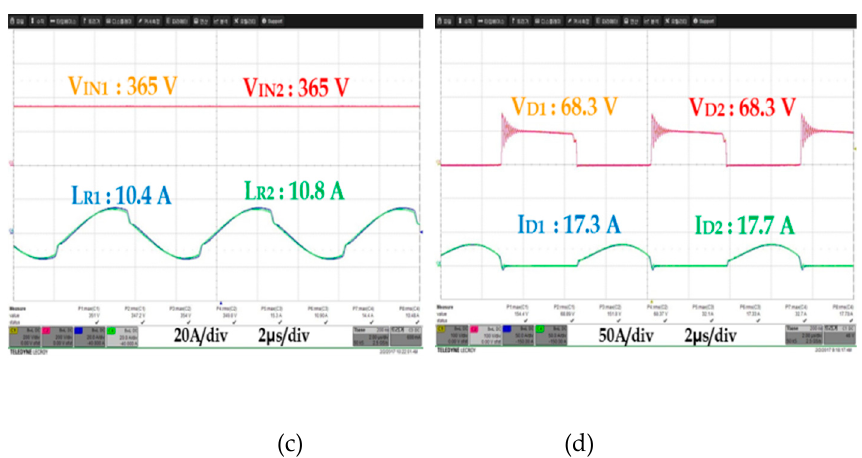
Figure 20. Experimental waveforms of the proposed converter (50% load). ( a ) Input and output voltage and output current; ( b ) FET D–S waveform; ( c ) input cap. Voltage/resonant current waveform; ( d ) voltage/current of the rectifier diode.